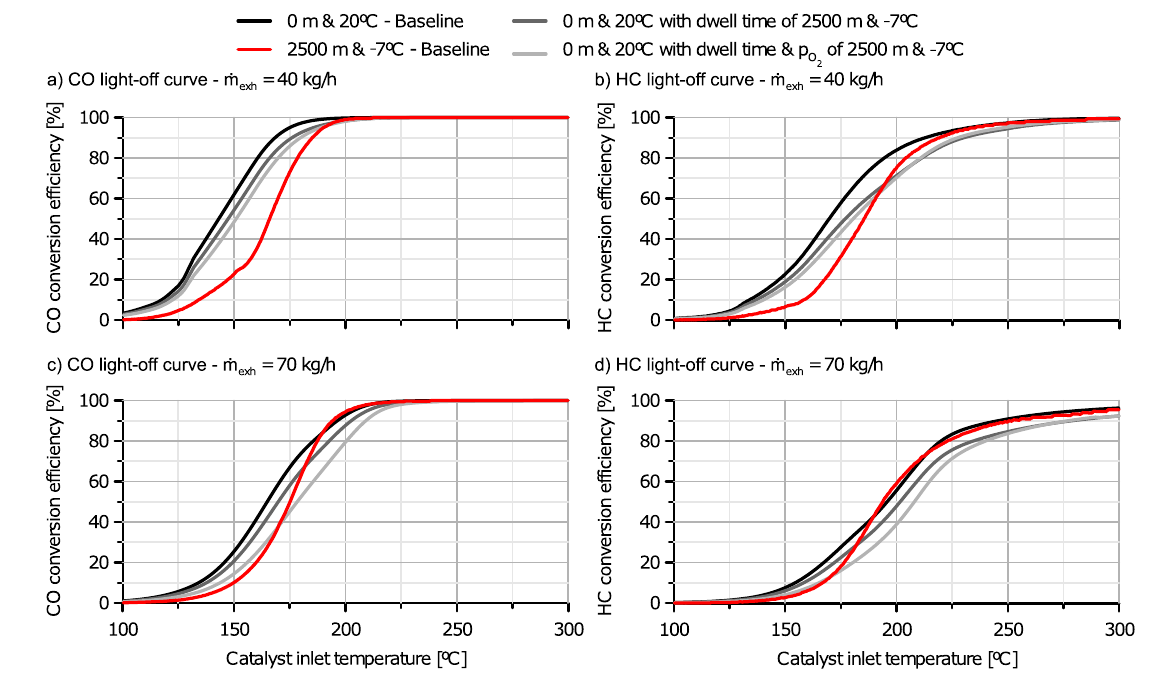
Figure 13. Progressive CO and HC light-off curves variation from warm sea-level to cold altitude case considering dwell time and reactants partial pressure separately: ( a ) CO light-off curve at 40 kg/h; ( b ) HC light-off curve at 40 kg/h; ( c ) CO light-off curve at 70 kg/h; and, ( d ) HC light-off curve at 70